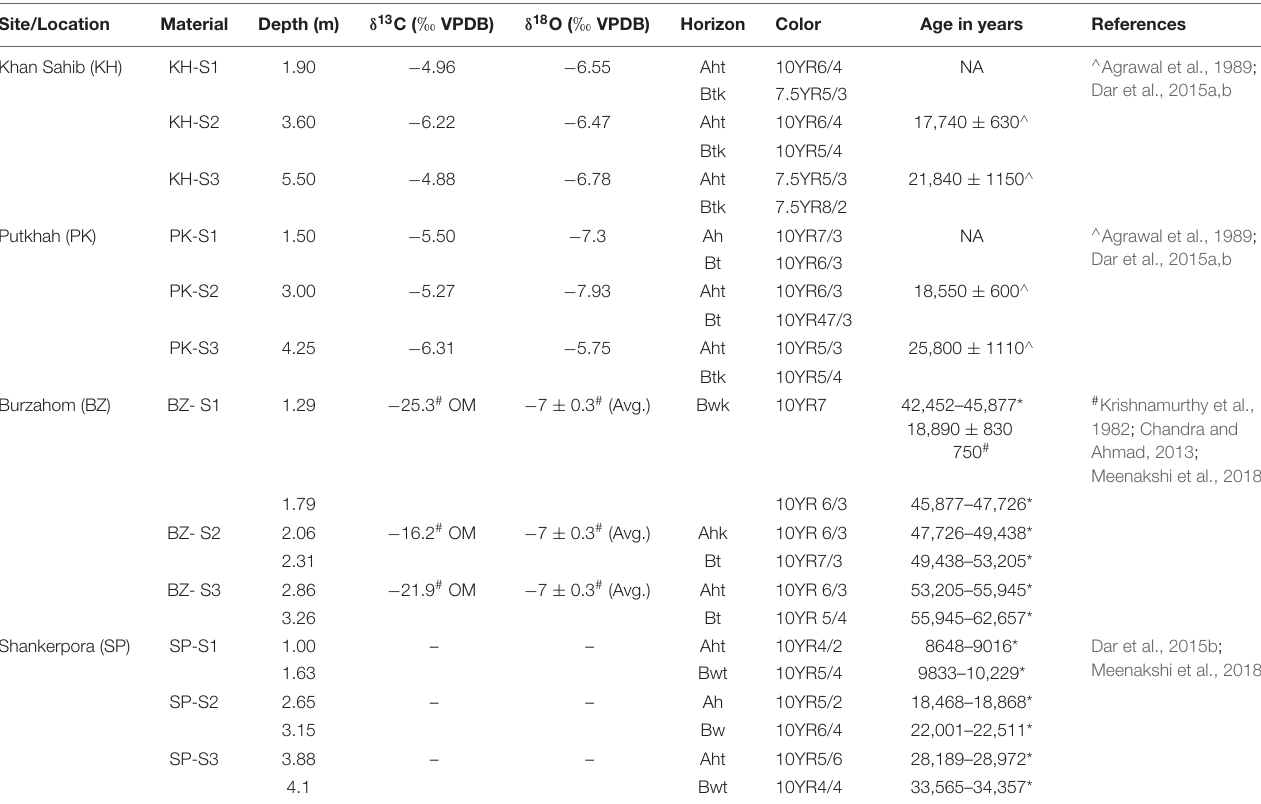
TABLE 3 | Pedological and isotopic characteristics of the top three palaeosols preserved across the Kashmir valley, and reference to key papers. Site/Location